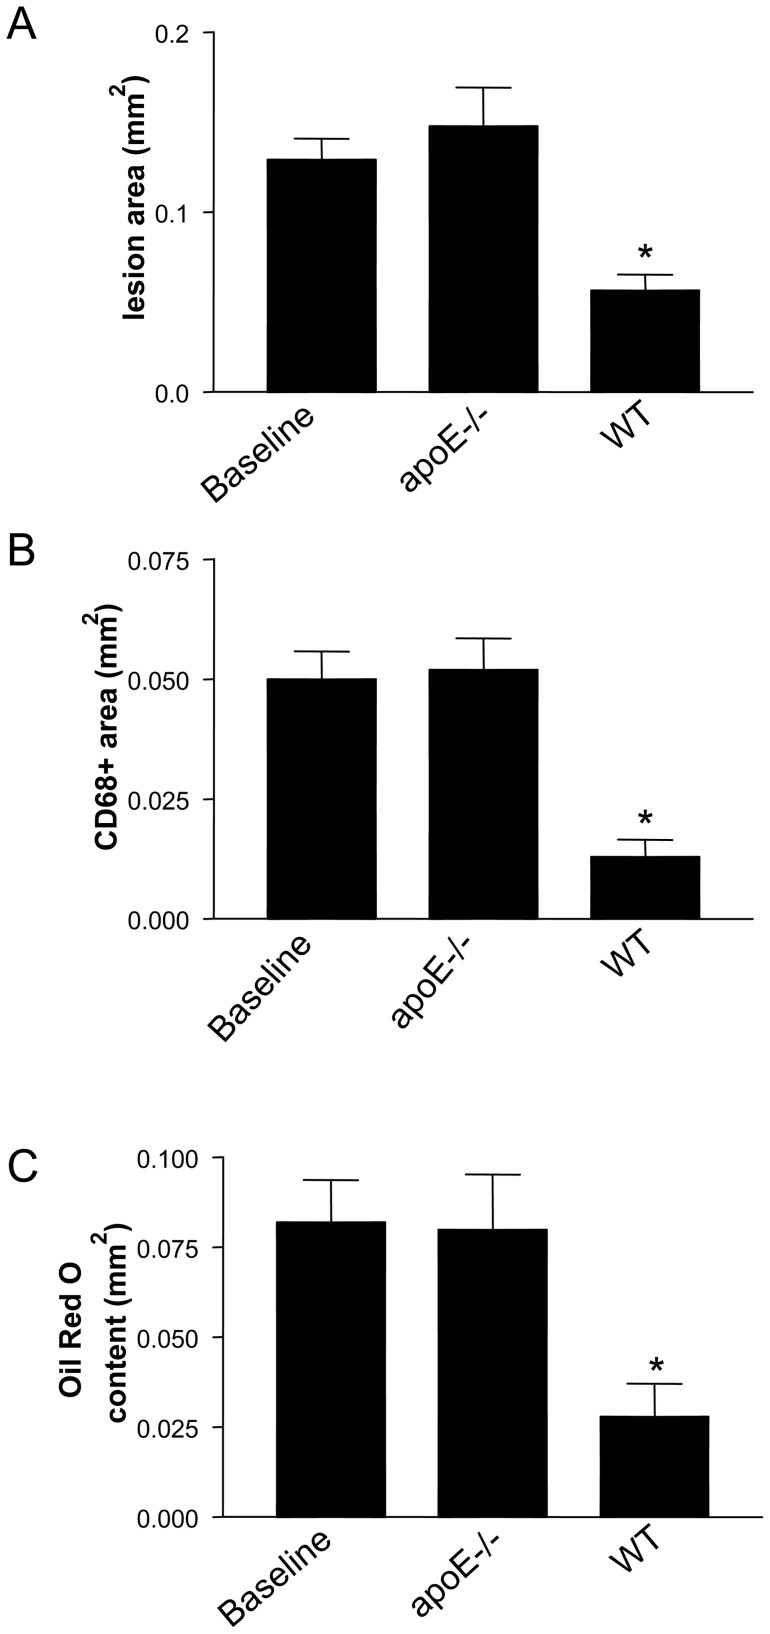
Transfer of plaques to a normolipidemic plasma environment decreases their size and reduces their burden of CD68+ cells and cholesteryl esters.Transplantation experiments were performed as described in Methods. Reversal of dyslipidemia (WT recipient) decreases plaque size (A) and CD68+ cell content (B) but continued dyslipidemia (apoE−/−) does not. Cholesteryl ester content was estimated by Oil Red O staining, which showed a decrease when the recipient was a WT mouse but not an apoE−/− mouse (C). The symbol * corresponds to statistical significance, p<0.05, when compared to donor apoE−/− mice (Baseline).